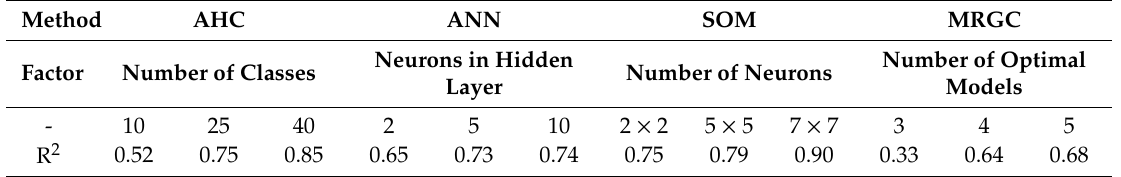
Table 3. R 2 values for each of the combinations of machine learning algorithm parameters used in this study. SOM with 7 neurons was observed to be the best among the examined methods. Method AHC ANN